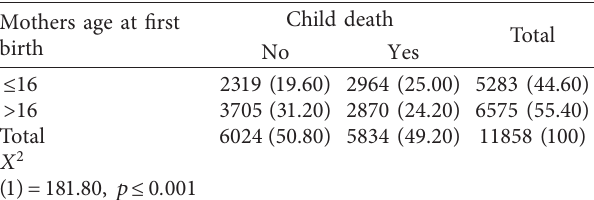
Table 8: Age of mothers at first birth on child